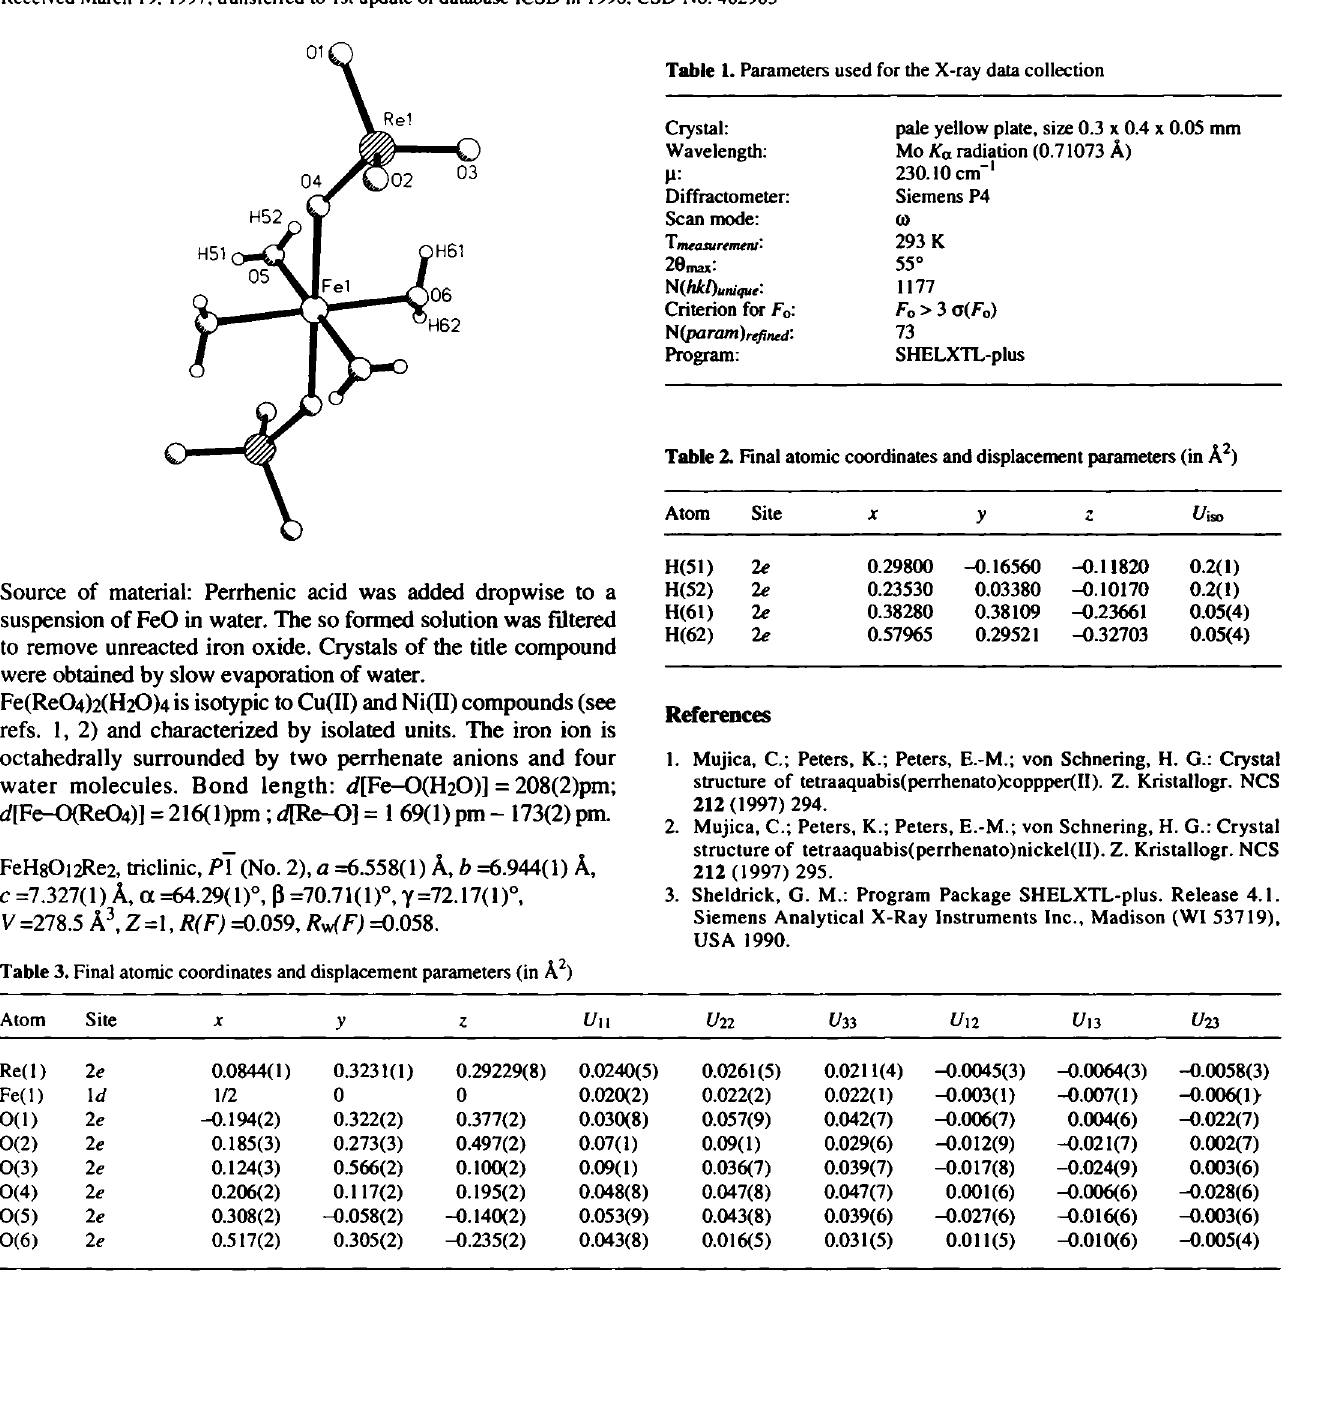
Table 1. Parameters used for the X-ray data collection